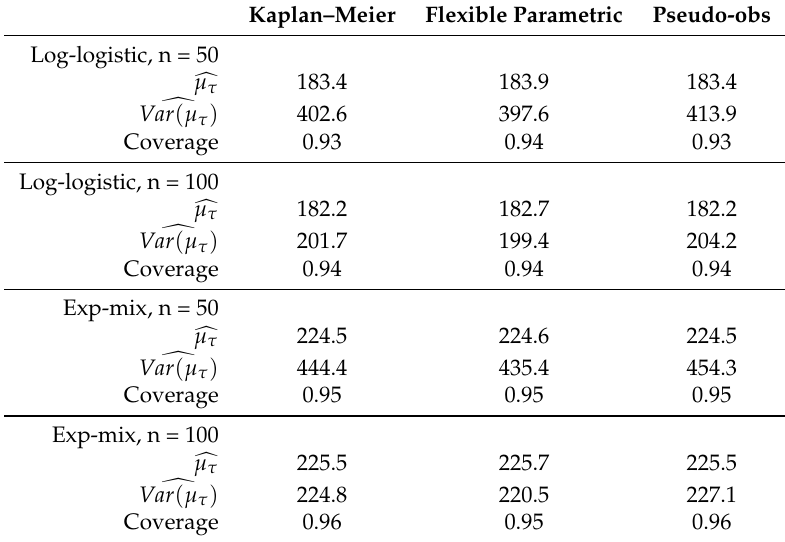
Table 2. Efficacy and 95 % confidence interval probabilities of the different RMST estimators at the mean survival time of 365 days, with the expected µ τ of 182 days for the Log-logistic distribution and 225 days for the exponential